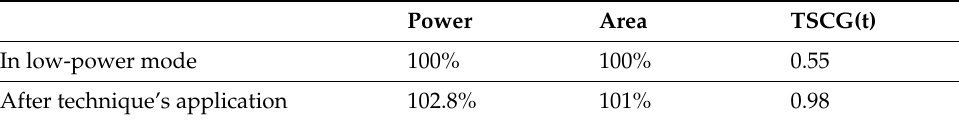
Table 3. Effects of the technique’s application (power and area normalized to the initial